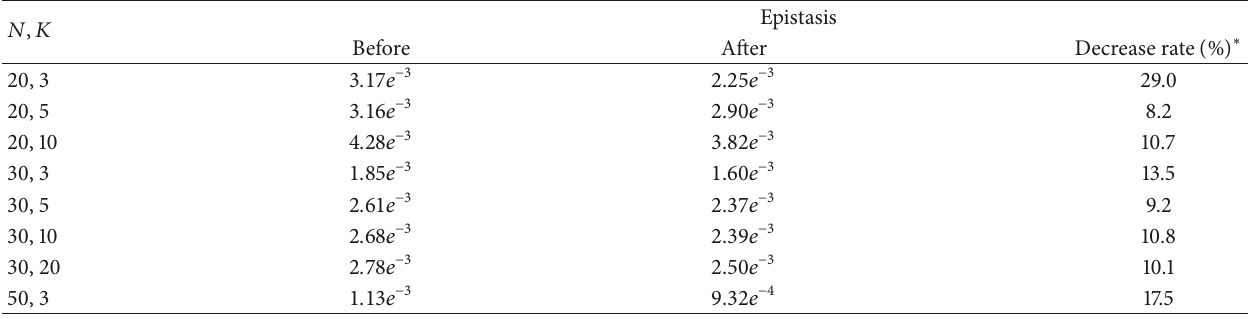
Table 6: Epistasis of the original and modified basis sampling in the NK -landscape problem. 𝑁, 𝐾 Epistasis Before After Decrease rate ( % ) ∗ 20, 3 3.17𝑒 −3 2.25𝑒